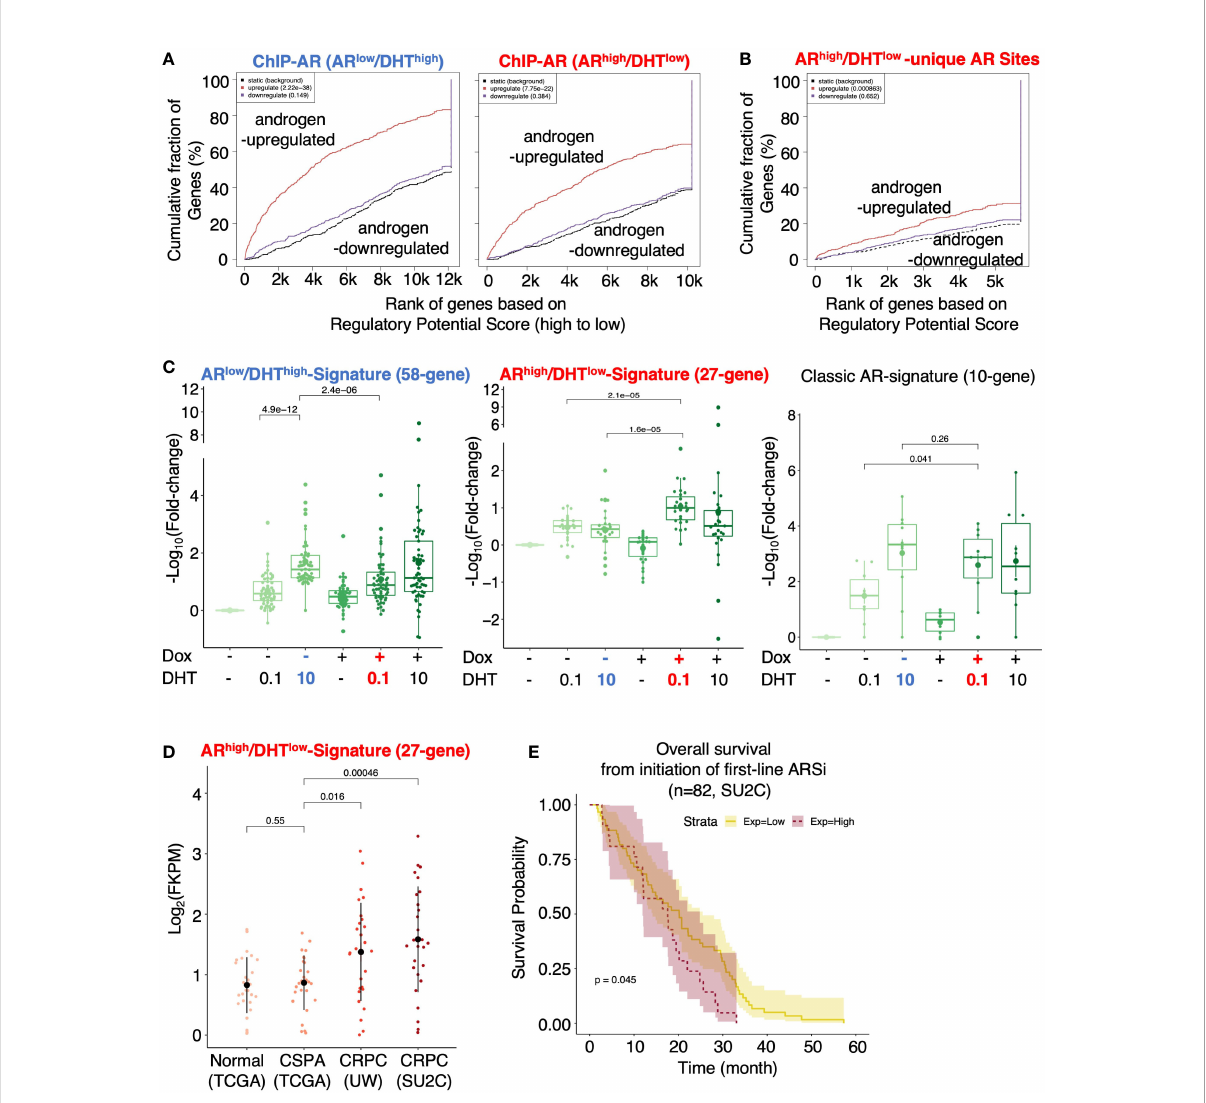
FIGURE 3 Identi fi cation of AR direct targets in AR high /DHT low cells. (A, B) Binding and Expression Target analysis (BETA) for the association of AR binding sites (ChIP-AR) and DHT-regulated genes in AR low /DHT high or AR high /DHT low cells (A) and the AR high /DHT low -unique AR binding sites and DHT- regulated genes in AR high /DHT low cells (B) . (C) Boxplot for AR low /DHT high unique AR signature (58-gene), AR high /DHT low unique AR signature (27- gene), and previously published classic AR targets (10-gene) in LNCaP-tet-AR cells under indicated conditions. (D) The expression levels of AR high /DHT low -unique AR signature in TCGA (normal and primary PCa), UW (mCRPC), and SU2C (mCRPC) datasets. (E) Kaplan-Meier survival analysis for the overall survival from the initiation of the fi rst-line ARSi in mCRPC patients (SU2C cohort) with higher scores (purple, top 25%) of the signature versus the lower scores (yellow, bottom